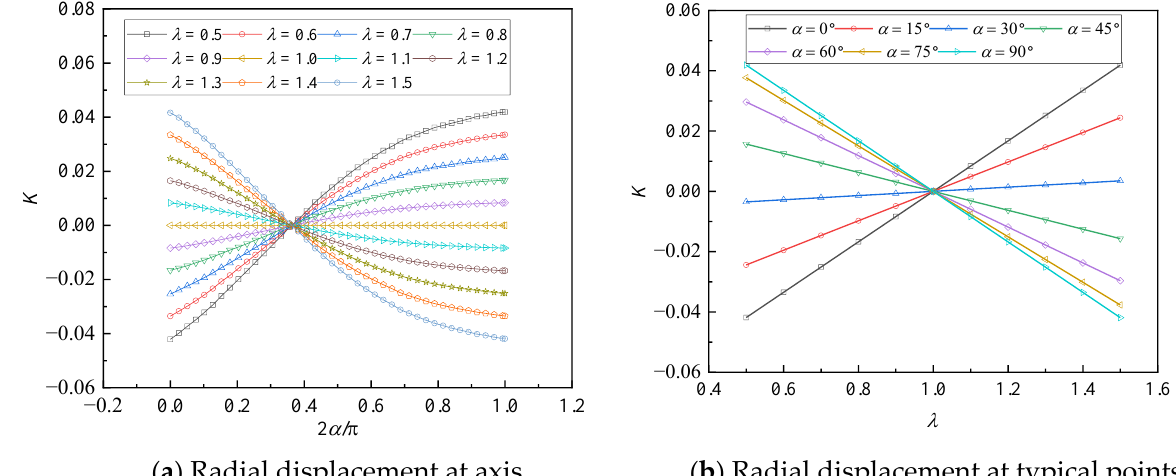
Figure 8. Radial displacement in the single factor test of parameter λ .